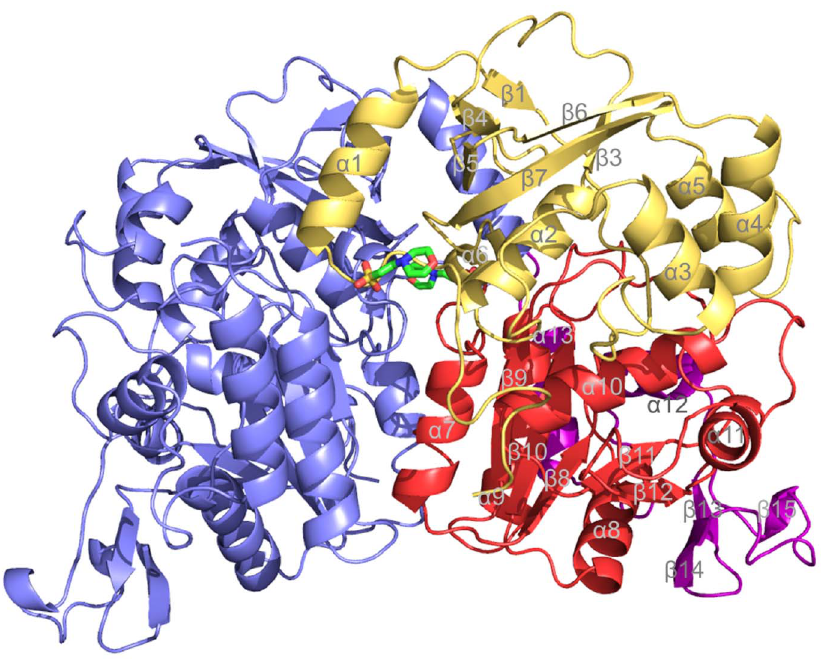
Figure 2. Structure of ATPS from A.vinosum organized as a homodimer with a size of 70 6 50 6 50 A˚ 3 . The subunits are drawn in blue and red/orange; domains I, II and III of one subunit in orange, red and dark red. 2N-Morpholino-ethansulfonic acid (MES) is shown as stick model.